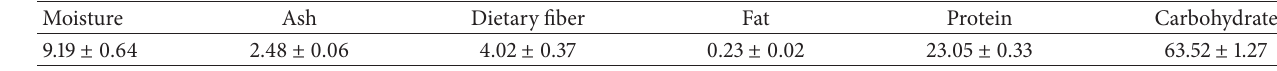
Table 1: Proximate composition of O. japonicus tubers (g/100g DW).